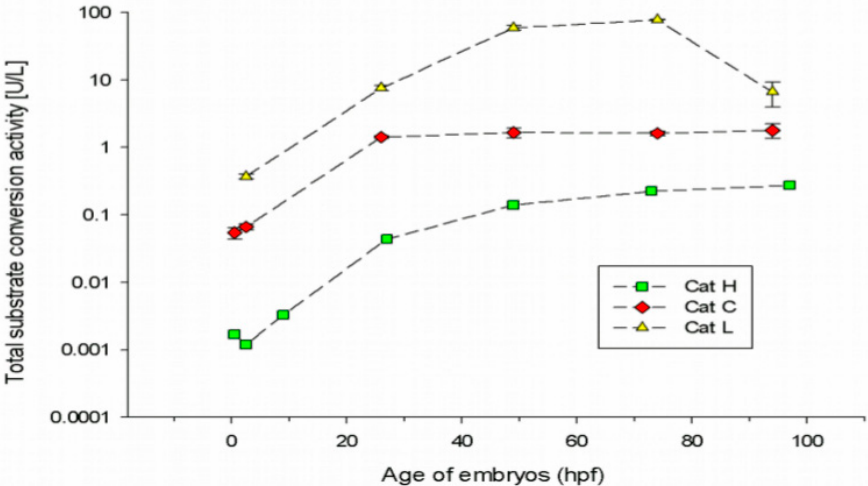
Figure 1. CatH ( ■ ), CatC ( ♦ ) and CatL ( ▲ ) total substrate conversion activity at five to seven different time points (0.5, 2.5, 9, 26, 49, 73 and 97 hpf) during the early development of zebrafish embryos. For each data point, ± SD of three replicates (30 fish embryos per replicate) are shown.